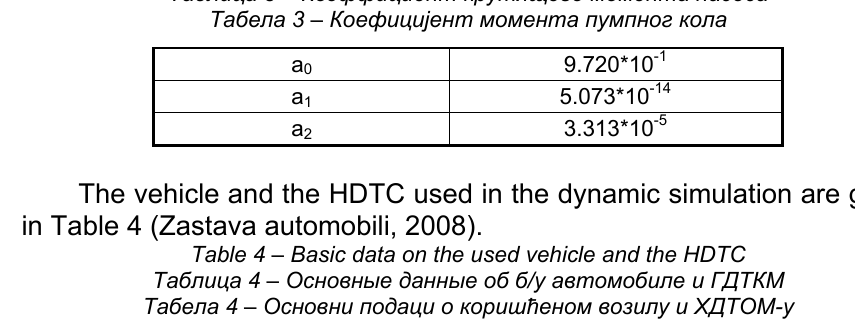
Table 3 – Coefficient of the pump torque